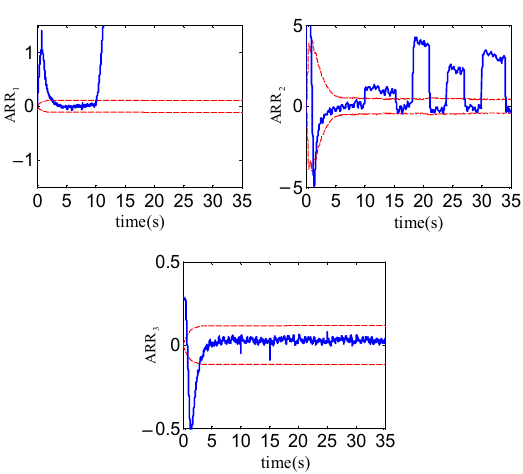
Figure 14. Residual responses of experiment.